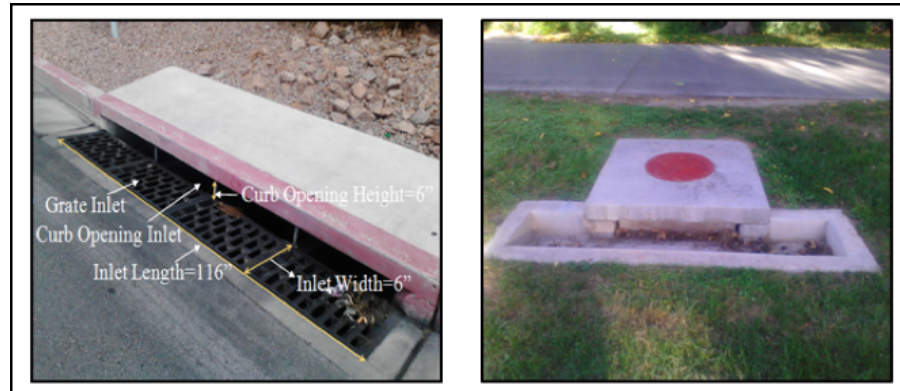
Figure 6. Storm drain inlet in Blacklot study site ( on the left ) and East Mall study site ( on the right ).